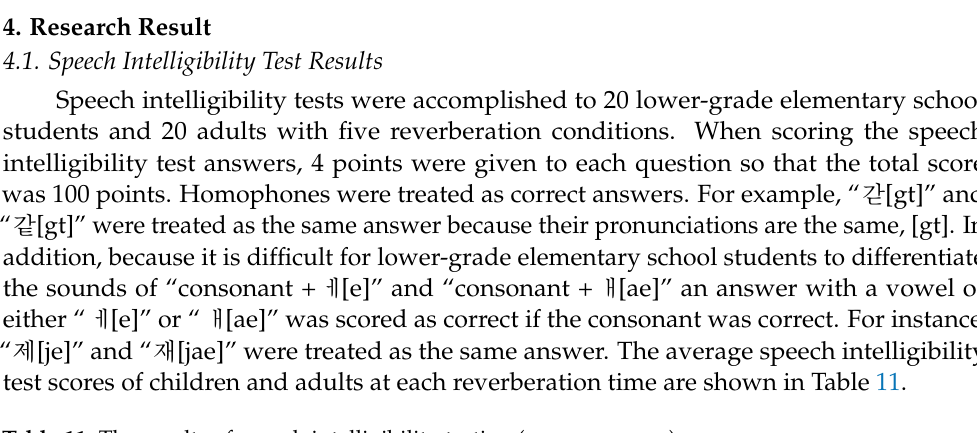
Table 11. The results of speech intelligibility testing (average